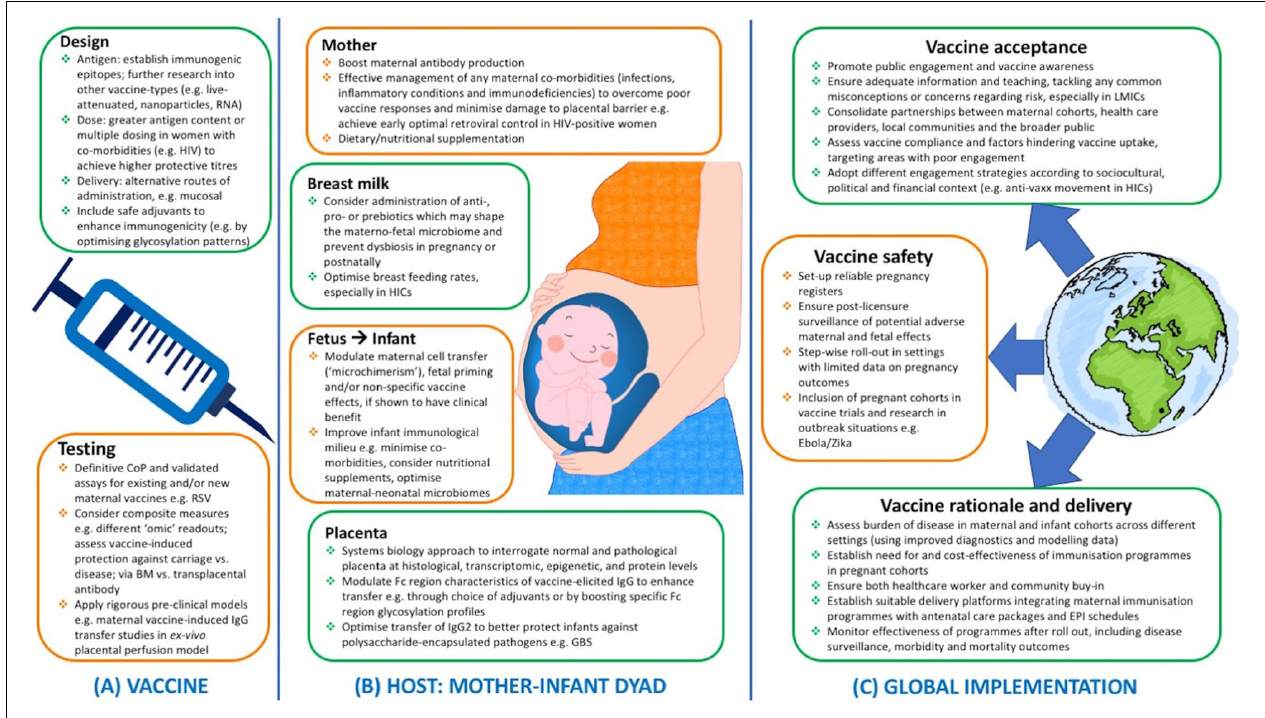
FIGURE 1 | Potential future strategies to ensure effective maternal immunization programs worldwide, from (A) vaccine design and testing, (B) optimal host responses at the maternal/fetal/infant levels, and (C) successful implementation at the global scale with consideration of key financial, political, socio-cultural, logistical influencing factors. LMICs, low- and middle-income countries; CoP, correlate of protection; BM, breast milk; EPI, expanded program of immunization; GBS, Group B streptococcus; HIC, high-income countries; HIV, human immunodeficiency virus; Ig, immunoglobulin; RSV, respiratory syncytial virus.